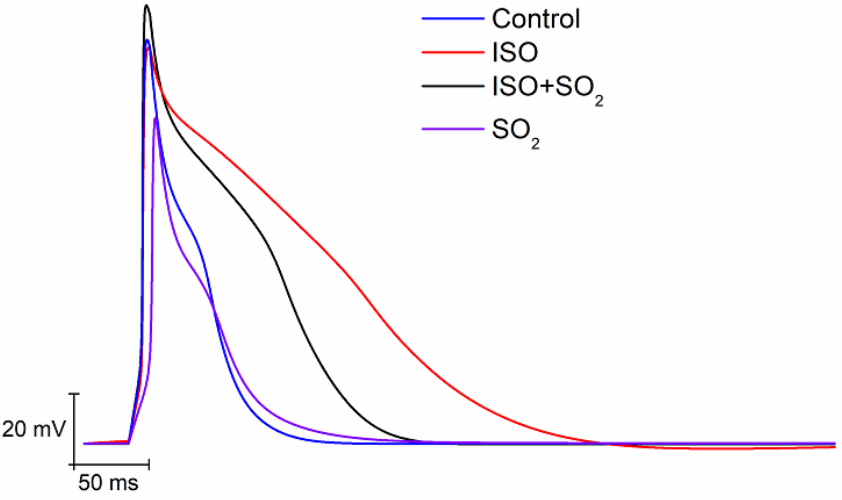
Figure 5. Ventricular action potentials of respective experimental groups were calculated by a mathematical model using equations from Şengül et al. 2020. Calculated action potentials corroborate the results obtained from electrophysiological experiments. Please see the Supplementary Material Figures S1-S4 and Table SI for detailed results of the ionic currents and